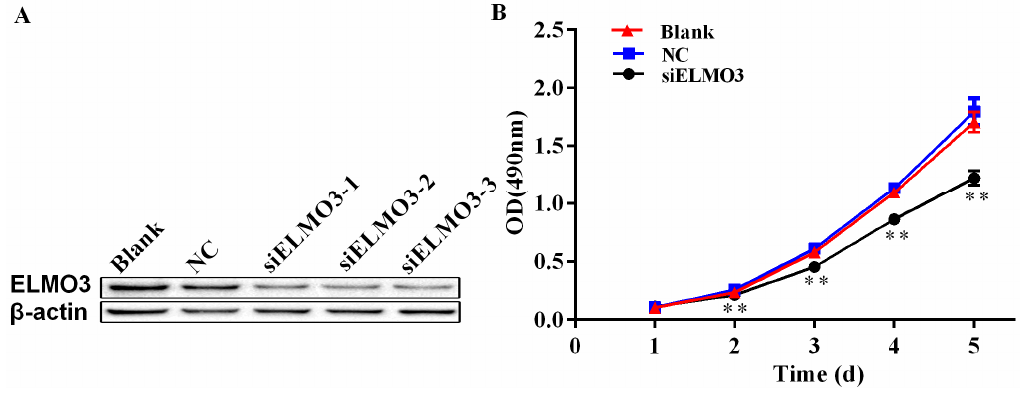
Figure 3. Knockdown of ELMO3 suppressed the proliferation of HCT116 cells. ( A ) The inhibition efficiency of the candidate ELMO3 siRNAs was determined by Western blot analysis. β -actin was used as a loading control. The result shows that siELMO3-3 had the highest silencing efficiency; ( B ) An MTS assay determined the effect of silencing ELMO3 on the proliferation capacities of HCT116 cells. NC represents negative control group. Values represent the mean ± SD of the absorbance at various time points ( n = 6, analysis of variance of factorial design). ** p < 0.01.